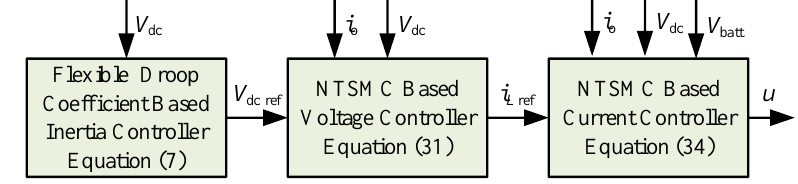
Figure 4. Cascade control flowchart.